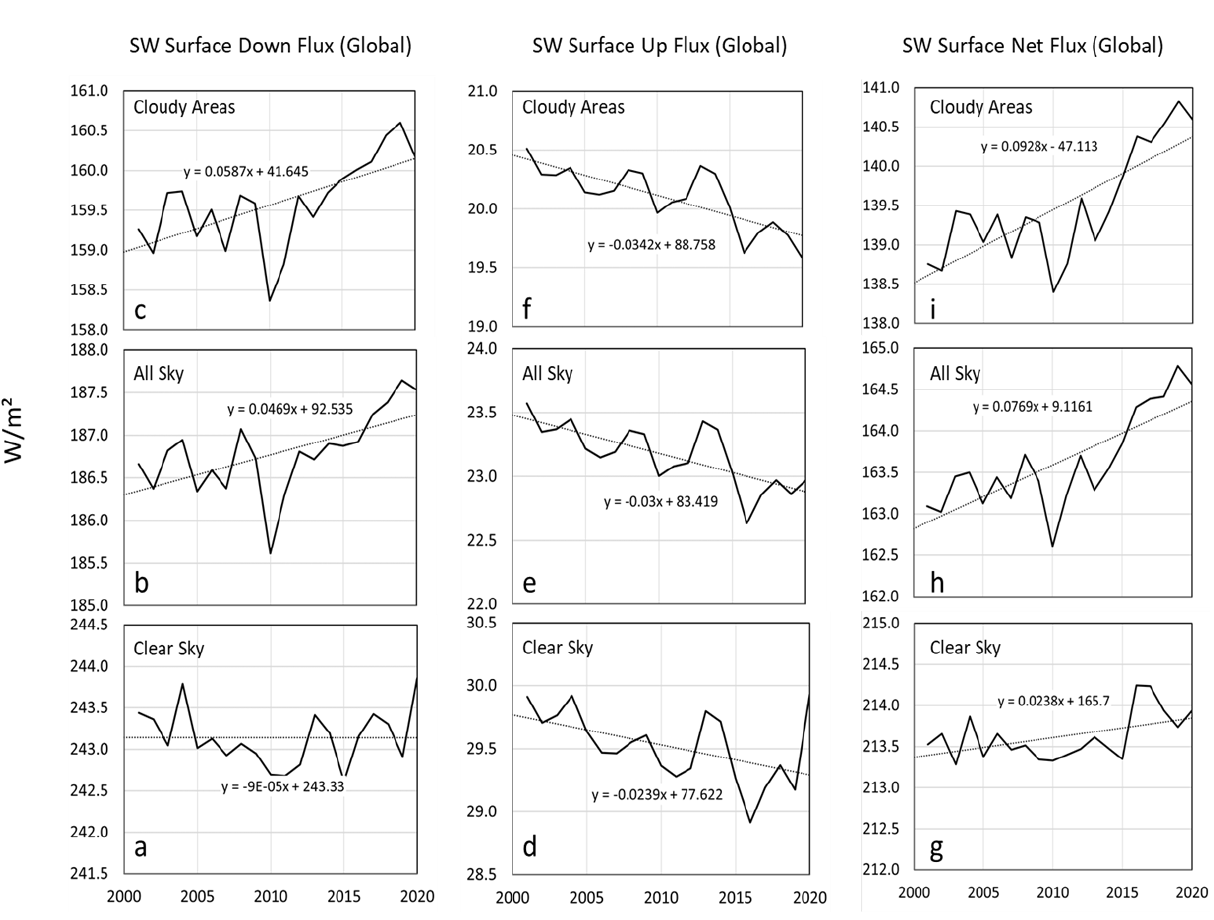
Figure 10. Global average SW downwelling ( a – c ), upwelling ( d – f ), and net ( g – i ) surface fluxes for “Clear Sky”, “All Sky”, and “Cloudy Areas” .